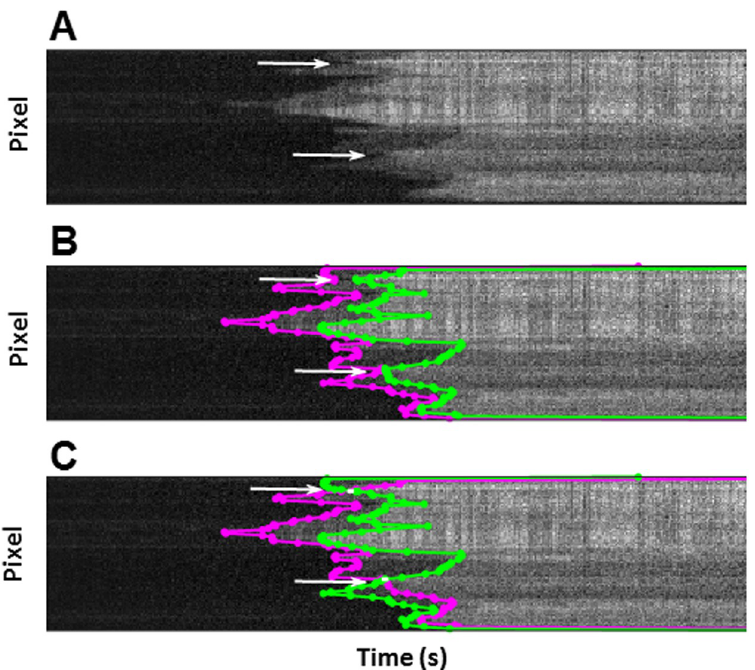
Fig 6. Identification and editing of crossing boundaries in complex kymographs. Processing of kymographs containing multiple nucleation points required the following general steps: (A) Identification of the crossing points; (B) detection of edges by intensity thresholding; and (C) the final editing generating, in this example, crossing points between